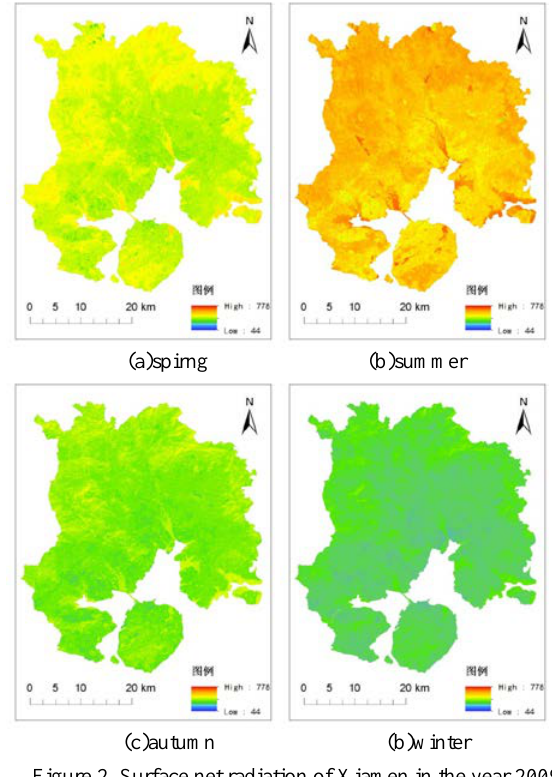
Figure 2. Surface net radiation of Xiamen in the year 2009